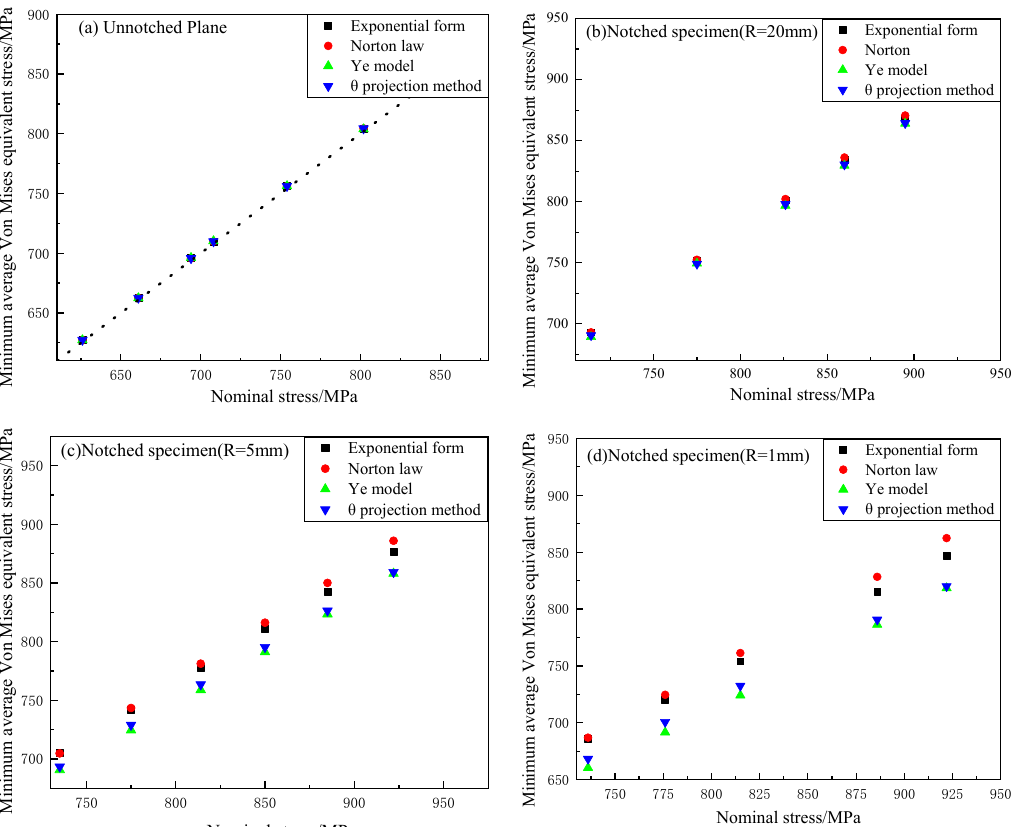
Figure 10. The MAVES vs. nominal stress: ( a ) Unnotched specimen; ( b ) Notched specimen (R = 20 mm); ( c ) Notched specimen (R = 5 mm); ( d ) Notched specimen (R = 1 mm).